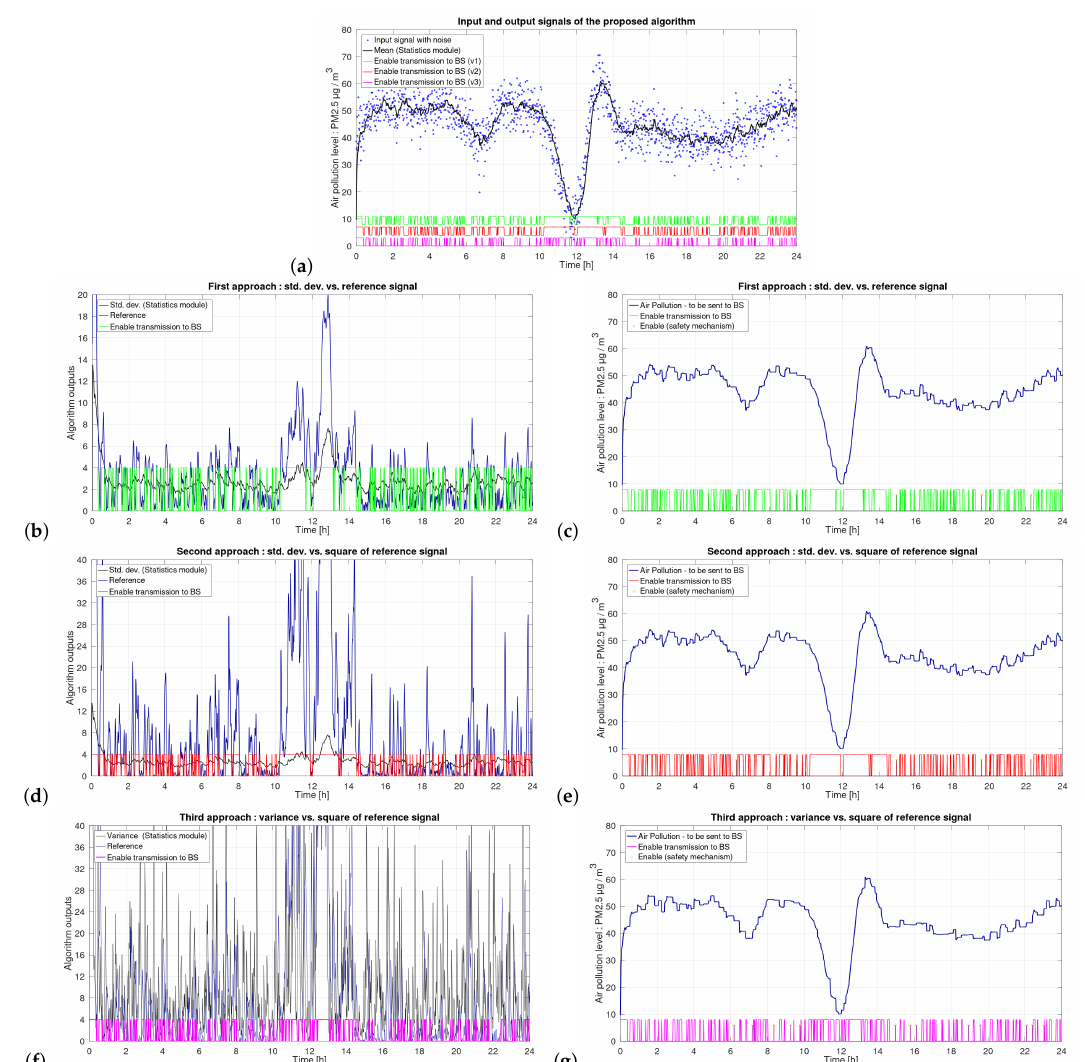
Figure 8. Simulation results of the proposed algorithm for large noise levels of c. 24 PM2.5 µ g/m 3 (40%) and the values of K and N lpf2 of 8. ( a ) Input signal with noise, corresponding mean signal, as well as transmission enable EN1, EN2 and EN3 signals, for three approaches given by Equations (7), (8) and (9), respectively; ( b ) Standard deviation, reference ( y Ref ) and EN1 signals; ( c ) Sensor output signal transmitted to the base station (BS) for approach 1; ( d ) Standard deviation, square of reference ( y 2 ) and EN2; ( e ) Sensor output signal transmitted to the BS for approach 2; ( f ) Variance, square of Ref reference ( y 2 ) and EN3 signals; ( g ) Sensor output signal transmitted to the BS for approach Ref